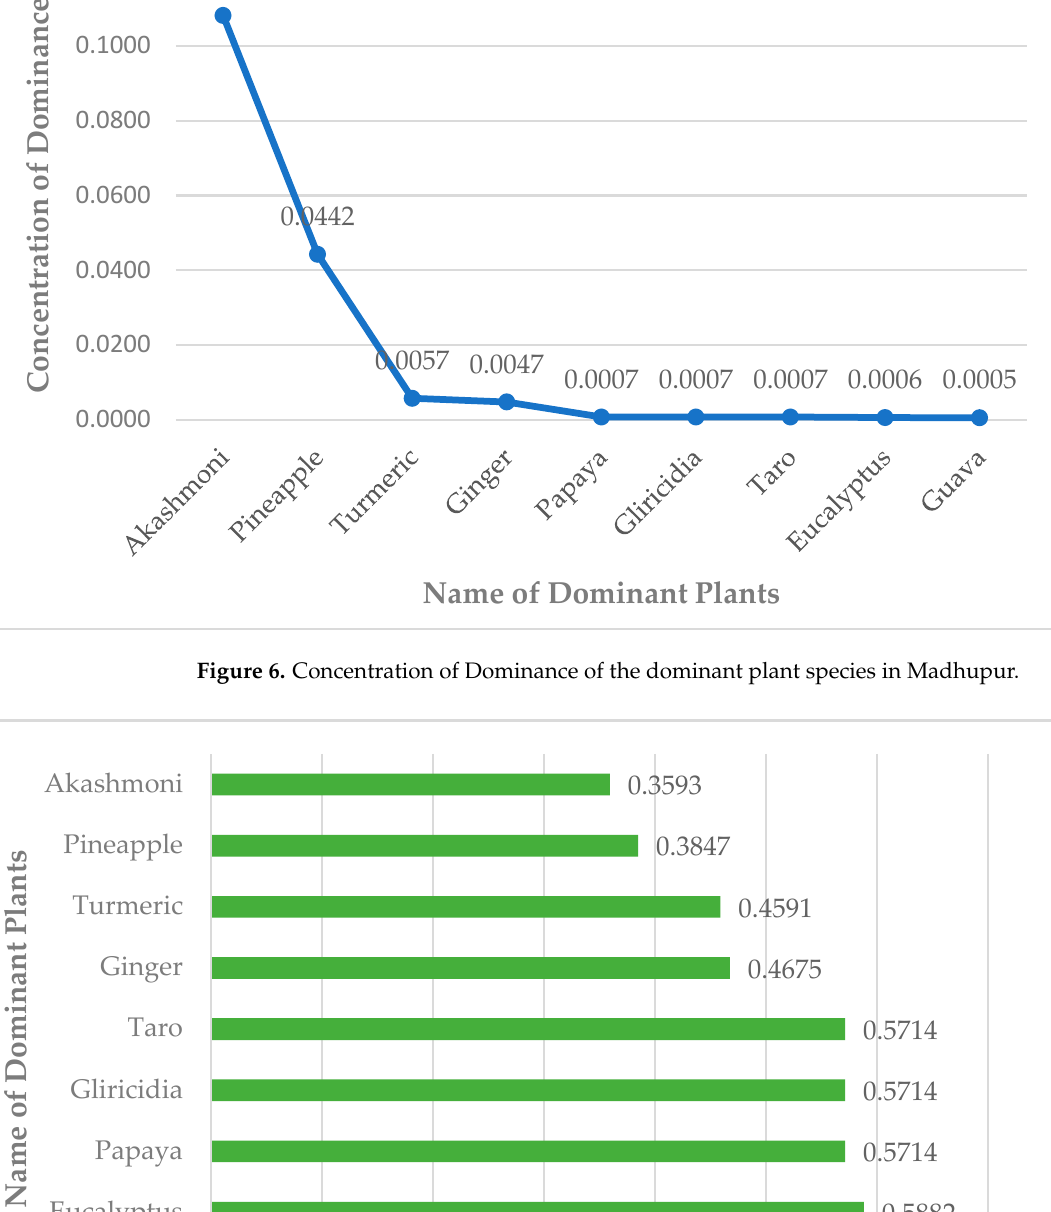
Figure 6. Concentration of Dominance of the dominant plant species in Madhupur.